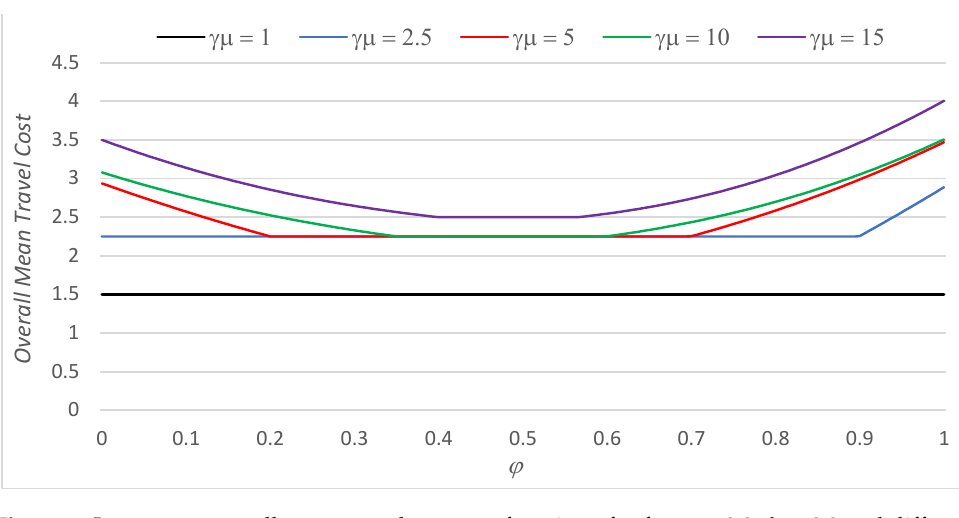
Figure 5. Long-term overall mean travel cost as a function of 𝜑 for 𝛼 = 0.1,𝛽 = 0.1 and different values of 𝛾𝜇 (case of linear link cost functions).